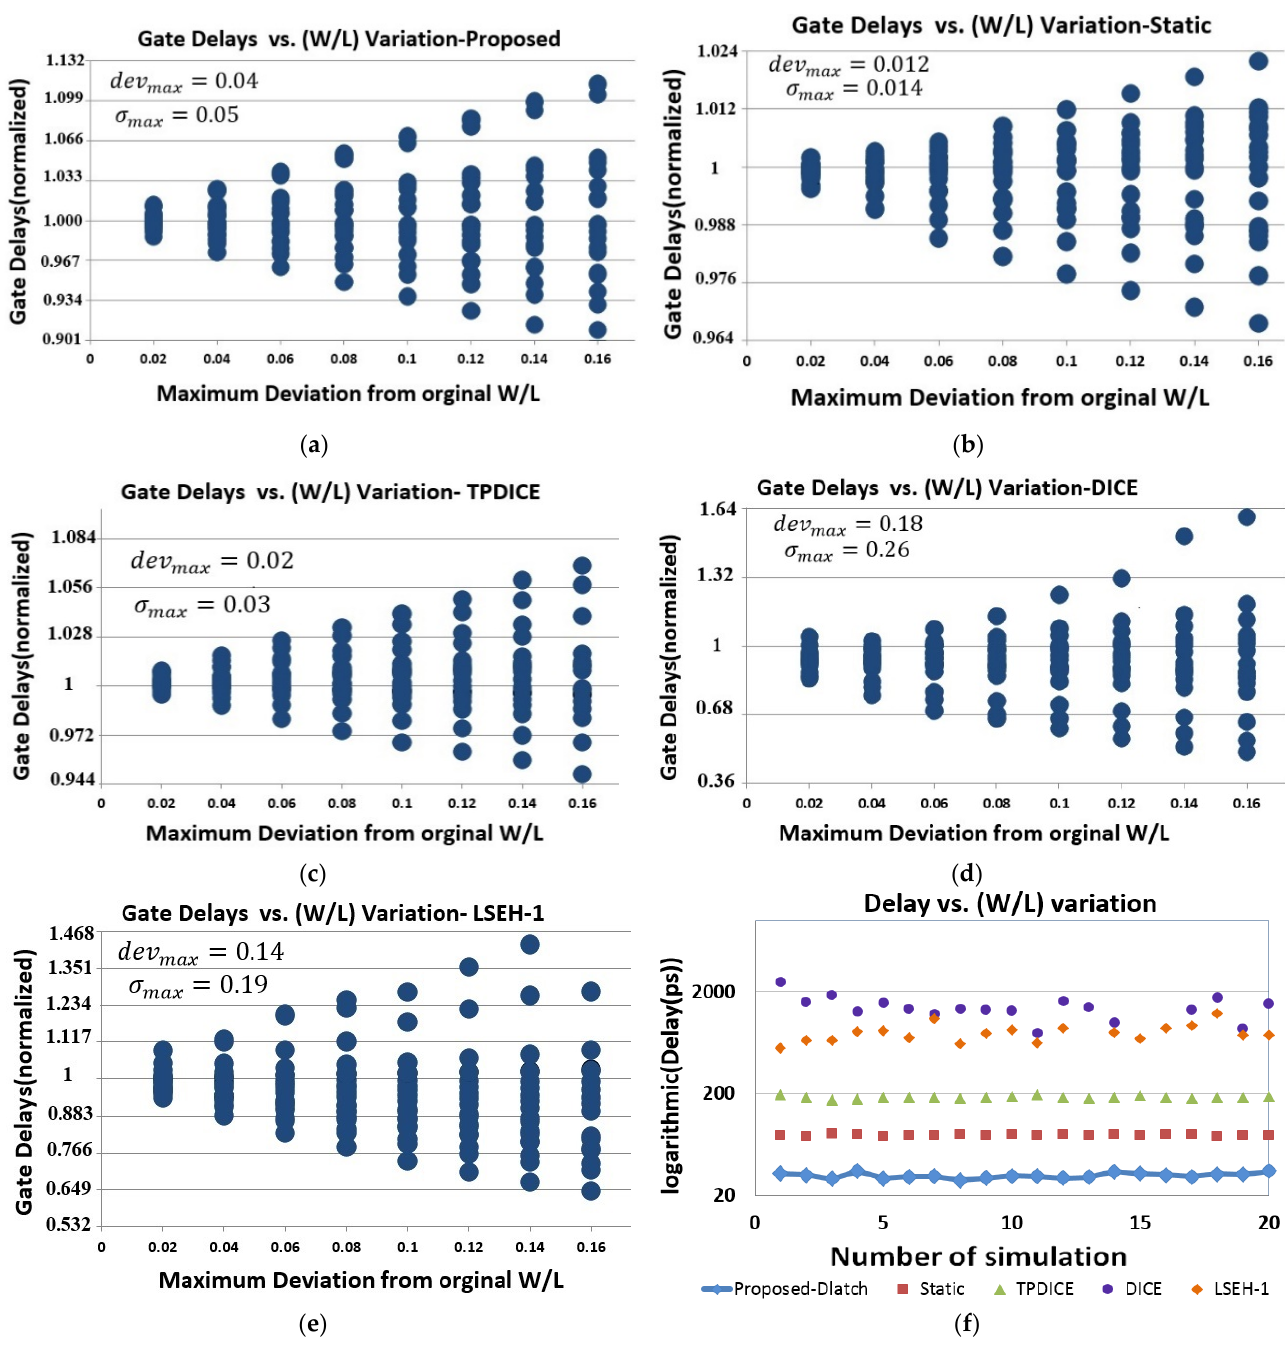
Figure 11. (W/L) variation effect on D-latch delay: ( a ) proposed D-latch; ( b ) Static D-latch ( c ) TPDICE-based D-latch ( d )